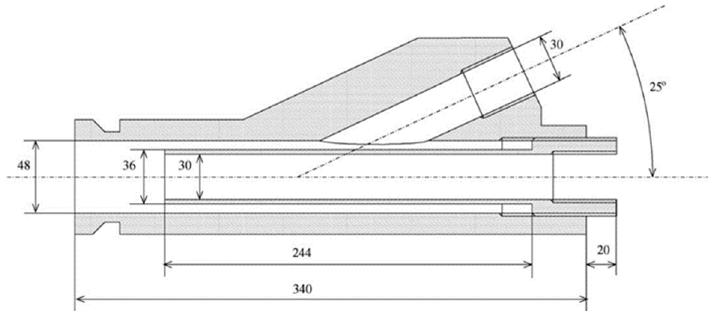
Figure 12. The dimensions of the original two-phase mixing pipe [54].